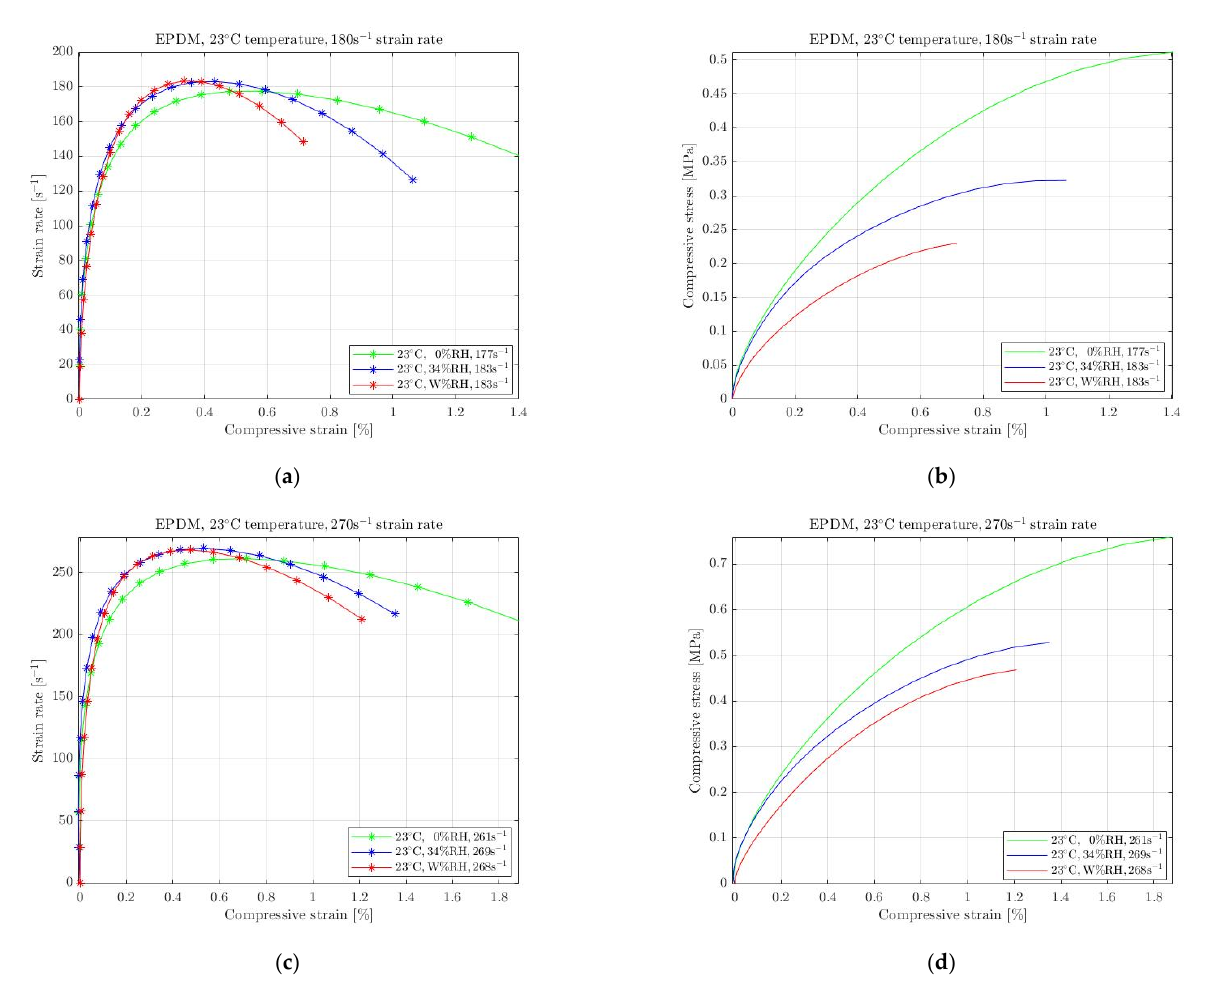
Figure 10. Strain rate vs. compressive strain ( a , c ) and compressive stress vs. compressive strain ( b , d ) of EPDM subjected to absolute wet (W% RH) and dry (0% RH) conditions at 23 °C temperature compared with the ambient conditions (34% RH) for 180 s − 1 ( a , b ) and 270 s − 1 ( c , d ) strain rate.